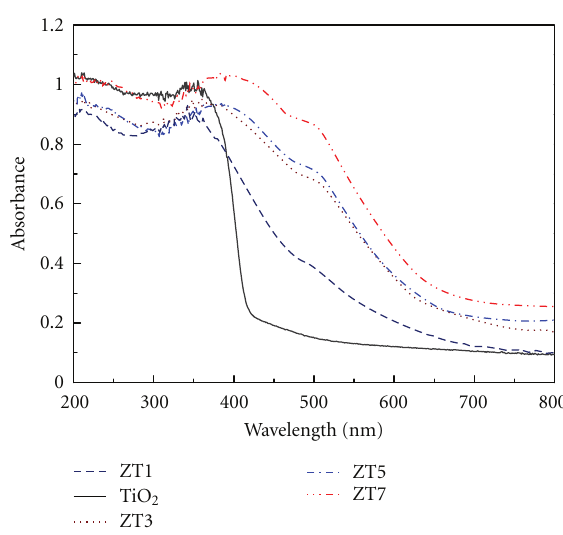
Figure 12: UV-vis spectra of pure TiO 2 and ZT series samples.